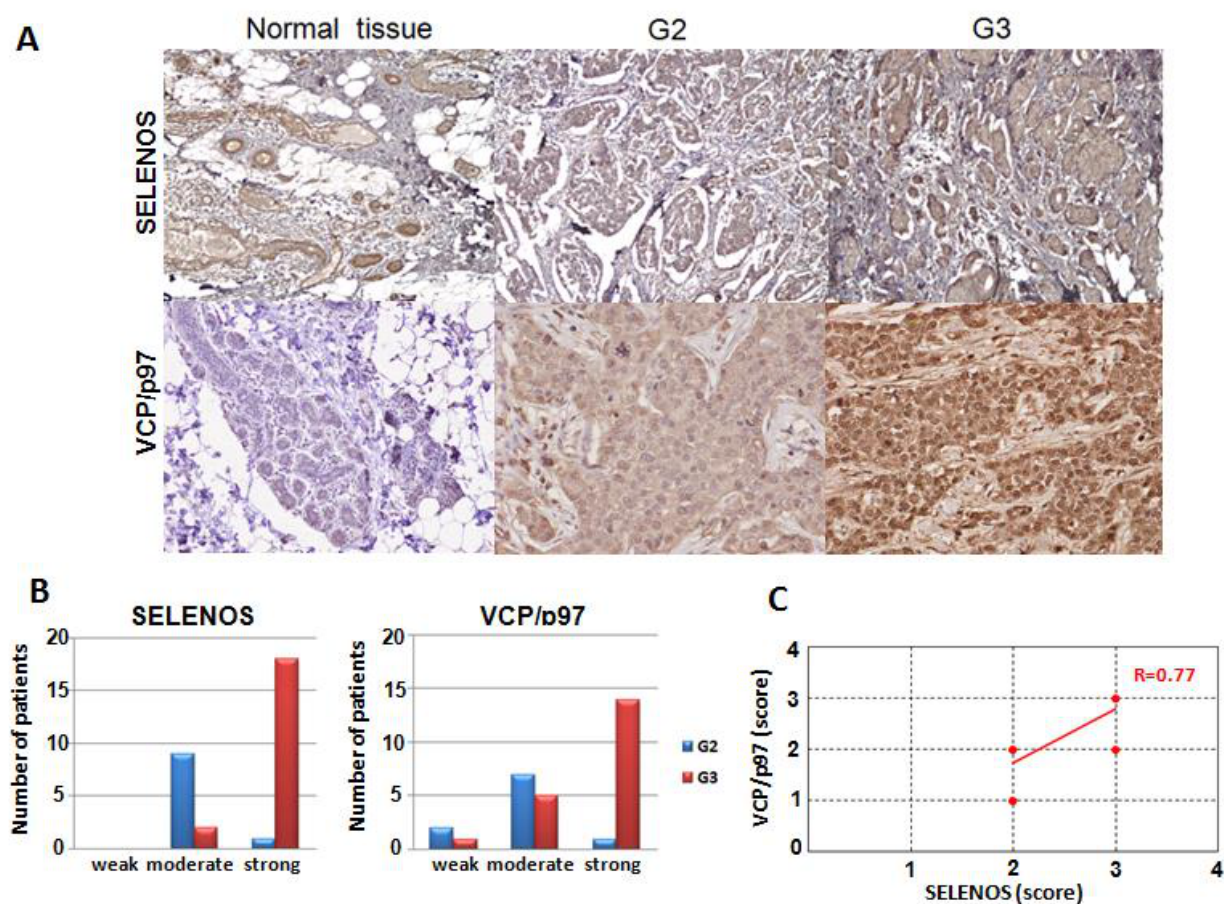
Figure 5. ( A ) Immunohistochemical expression of human SELENOS and VCP/p97 at 200 × mag- nification in normal mammary tissues and TNBC patients with grade 2 and 3. In grade 2 (G2) and grade 3 (G3) tissues the neoplastic cells form solid clusters separated by bands of connective tissue. ( B ) Correlation between SELENOS and VCP/p97 expression and tumor grading. ( C ) Pearson correlation between SELENOS and VCP/p97 scores obtained by IHC (R, correlation coefficient).